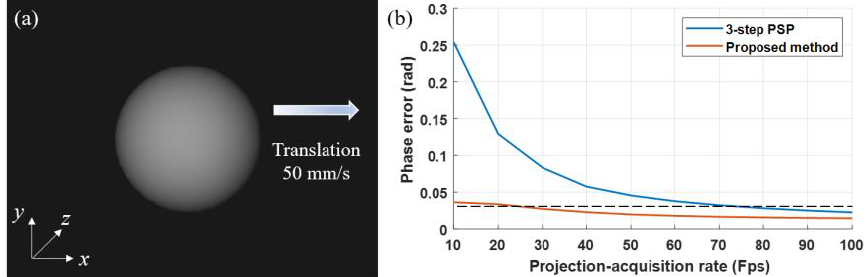
Figure 9. ( a ) Moving sphere with a speed of 50 mm/s in simulation scene. ( b ) The relationship between the projection–acquisition rate and phase error of the sphere. The dotted line represents the phase error of 0.01 𝜋 .